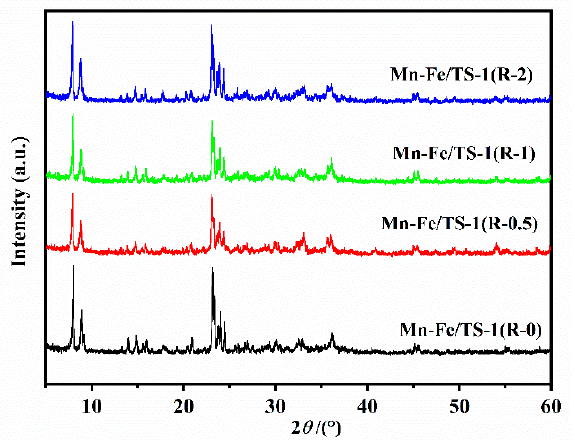
Figure 1. XRD patterns of Mn–Fe/TS-1(R-0), Mn–Fe/TS-1(R-0.5), Mn–Fe/TS-1(R-1), Mn–Fe/TS-1(R-2).